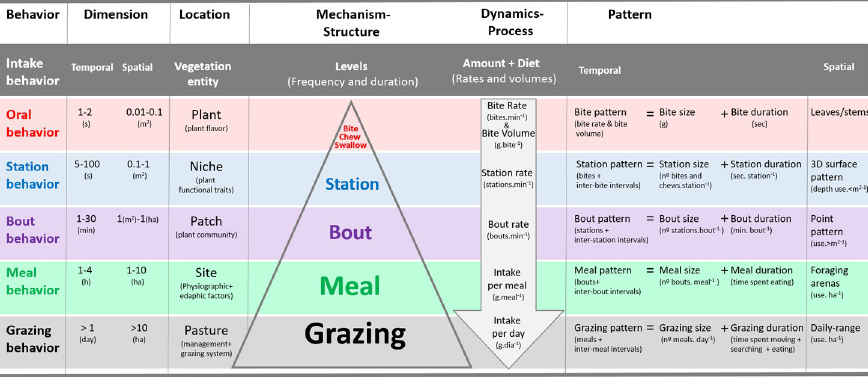
Fig 1. Components of grazing behaviour. Rows represent scale levels (behaviour units), columns represent hierarchical perspectives (dimensions, locations, structures, dynamics, and patterns). Patterns, at each scale, are generated by the distribution of frequencies, durations, rates, and volumes (based on the original conceptual model of ecological hierarchy of [24] and on contributions of [7, 15, 25]).